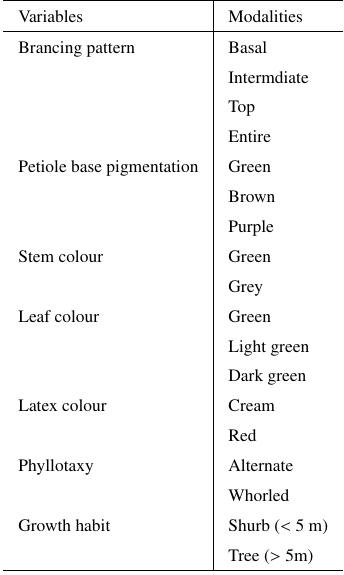
Table 1. Modalities of qualitative